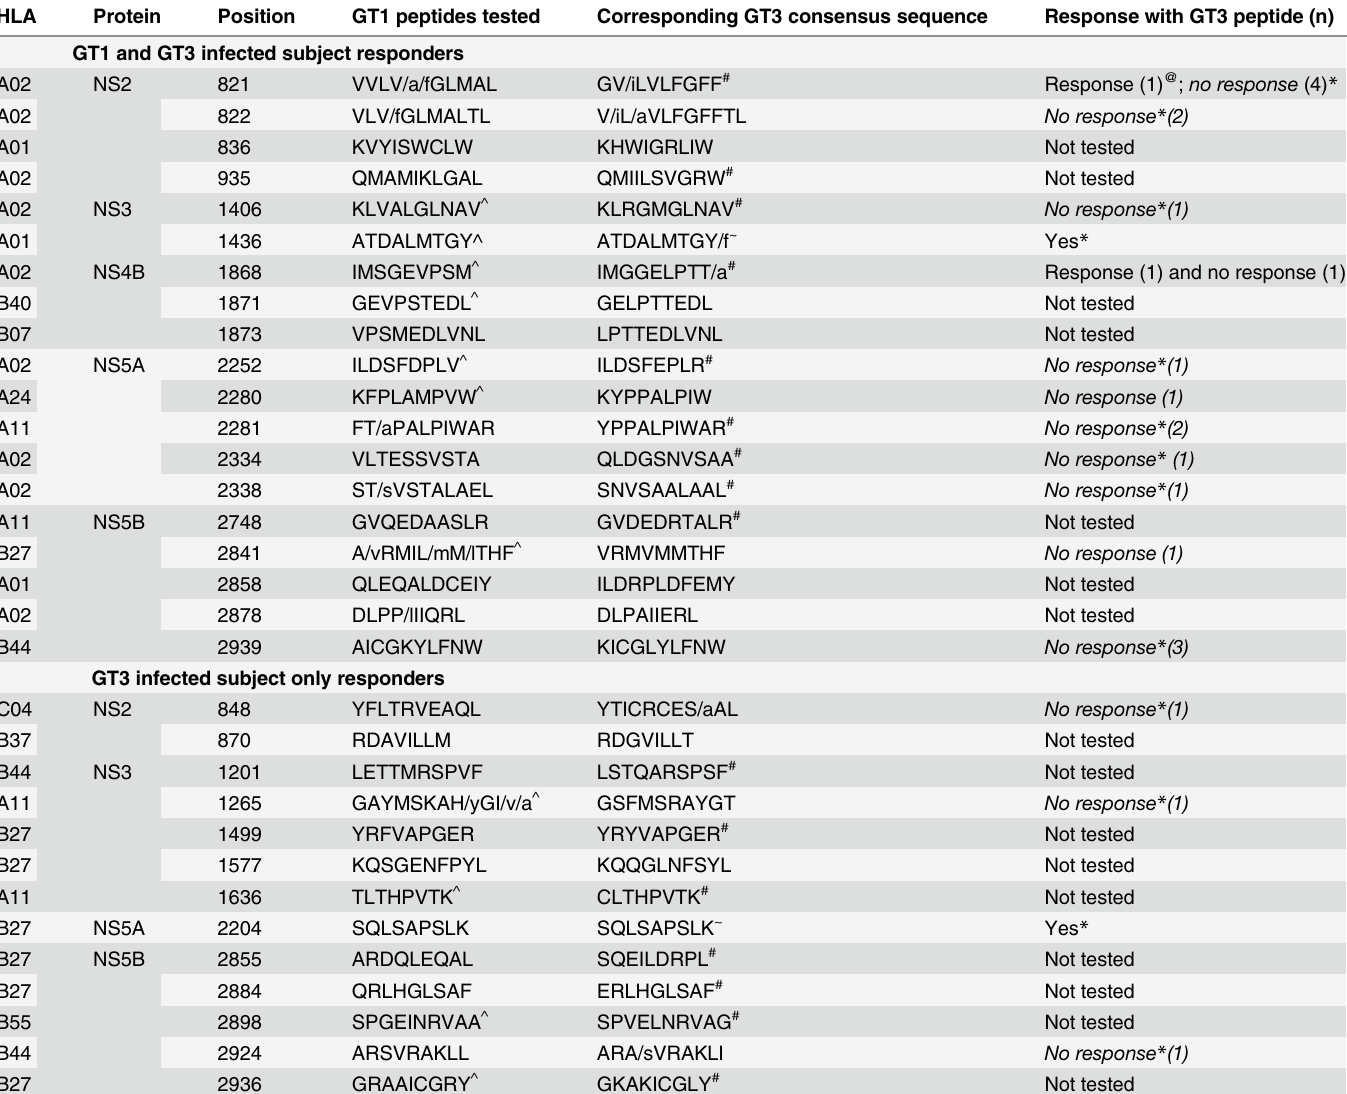
Table 2. GT1 peptides that elicit a response in non-GT1 infected